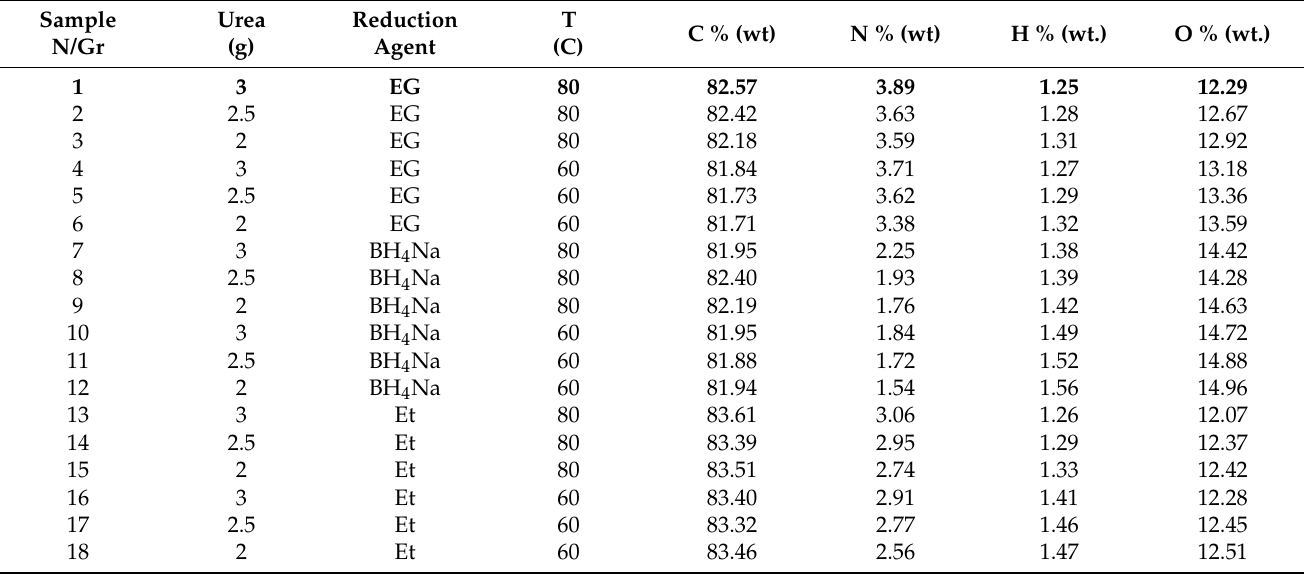
Table 2. Nitrogen-doped graphene oxide materials obtained by using the microwave method; comparison of N doping ratio based on experimental condition (organic nitrogen precursor: